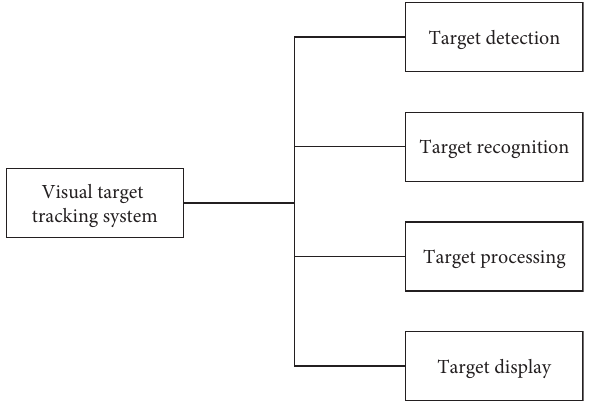
Figure 3: Main parts of visual target tracking